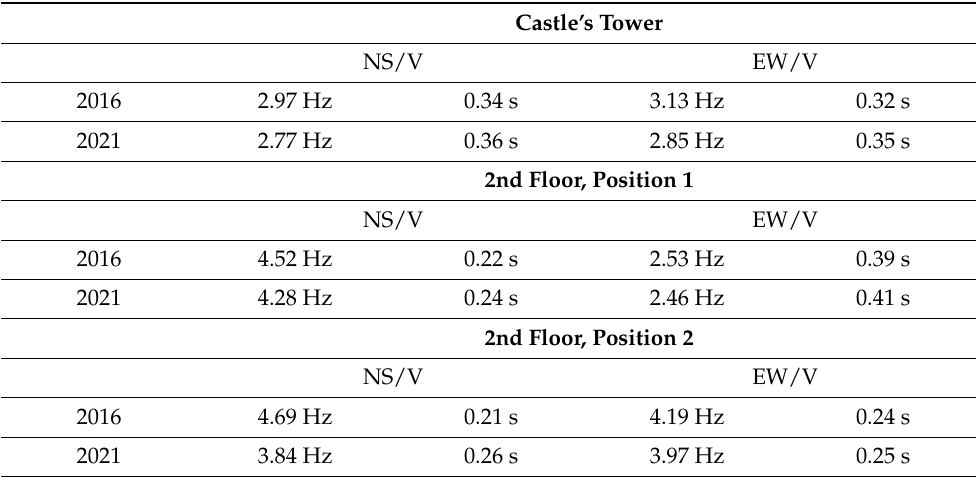
Table 1. Estimated fundamental frequencies and periods based on the 2016 and 2021 ambient noise